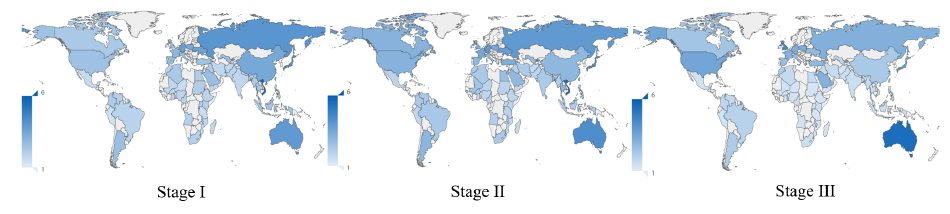
Figure 6. The performance score of countries in three